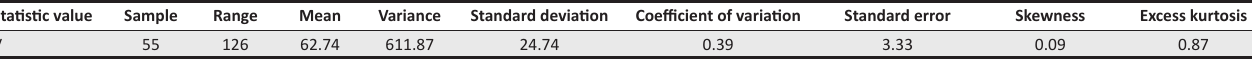
TABLE 2: Descriptive statistics of maximum annual daily rainfall